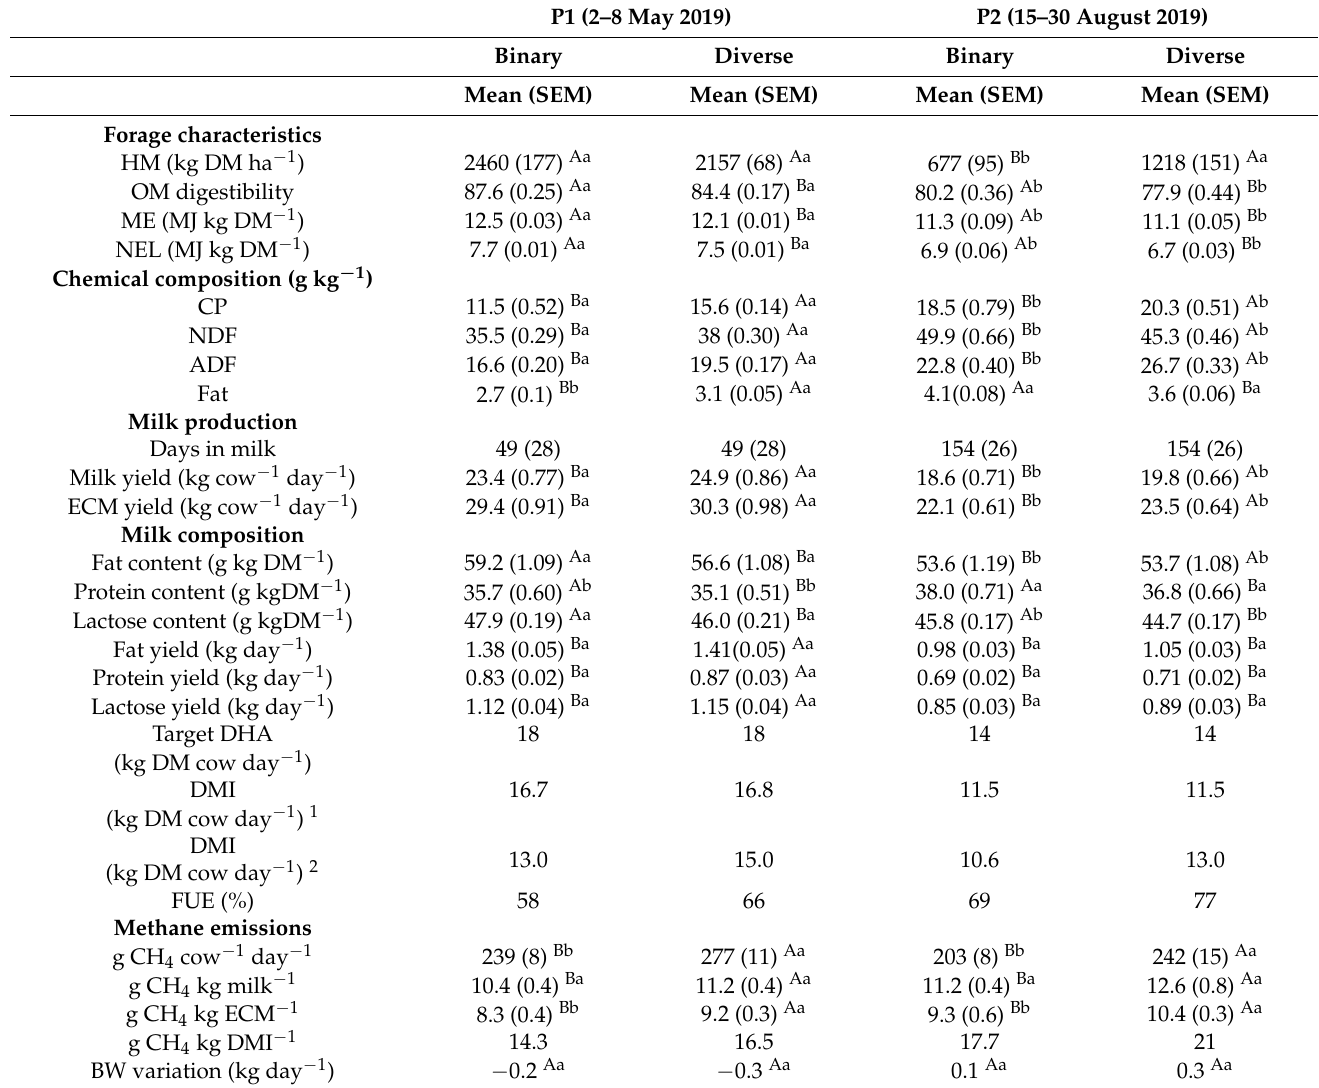
Table 3. Forage characteristics, milk production, target daily herbage availability, DM intake, herbage utilization, methane emissions, and body weight (BW) variation of dairy cows grazing on binary and diverse mixtures. Abbreviations are as follows (sorted alphabetically): ADF: acid detergent fiber, CP: crude protein, DHA: daily herbage allowance, DMI: dry matter intake, ECM: energy-corrected milk, FUE: forage use efficiency, HM: herbage mass, ME: metabolizable energy, NDF: neutral detergent fiber, and NEL: net energy for